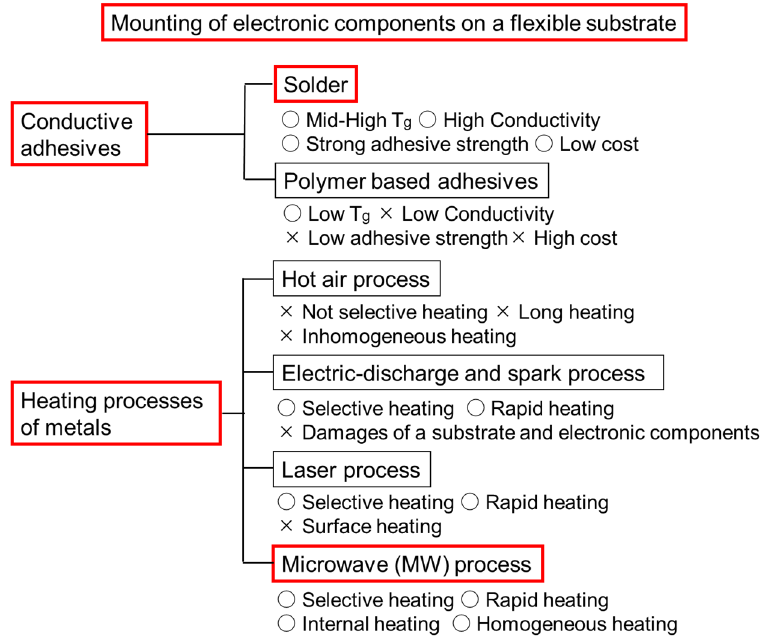
Figure 1. Candidates for conductive adhesives and heating processes of metal in mounting of electronic components on flexible substrate. Circle marks ( ○ ) and cross marks (×) mean desirable and undesirable properties in the mounting processes of electronic components on flexible substrate, respectively. Red squares highlight the focuses of this study.